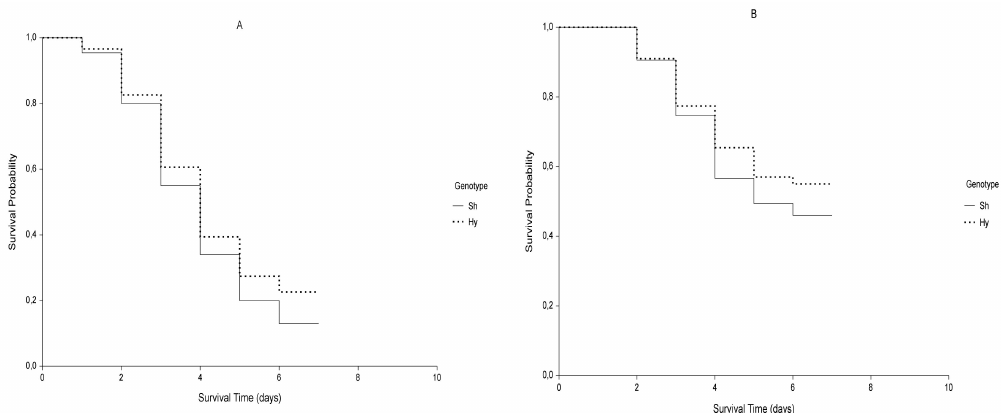
Figure 2. Kaplan-Meier estimates of survival functions of control ( A ; ψ = 0 MPa) and stressed ( B ; ψ = − 0.6 MPa) samples for genotypes Sh (continuous curve) and Hy (dotted curve).